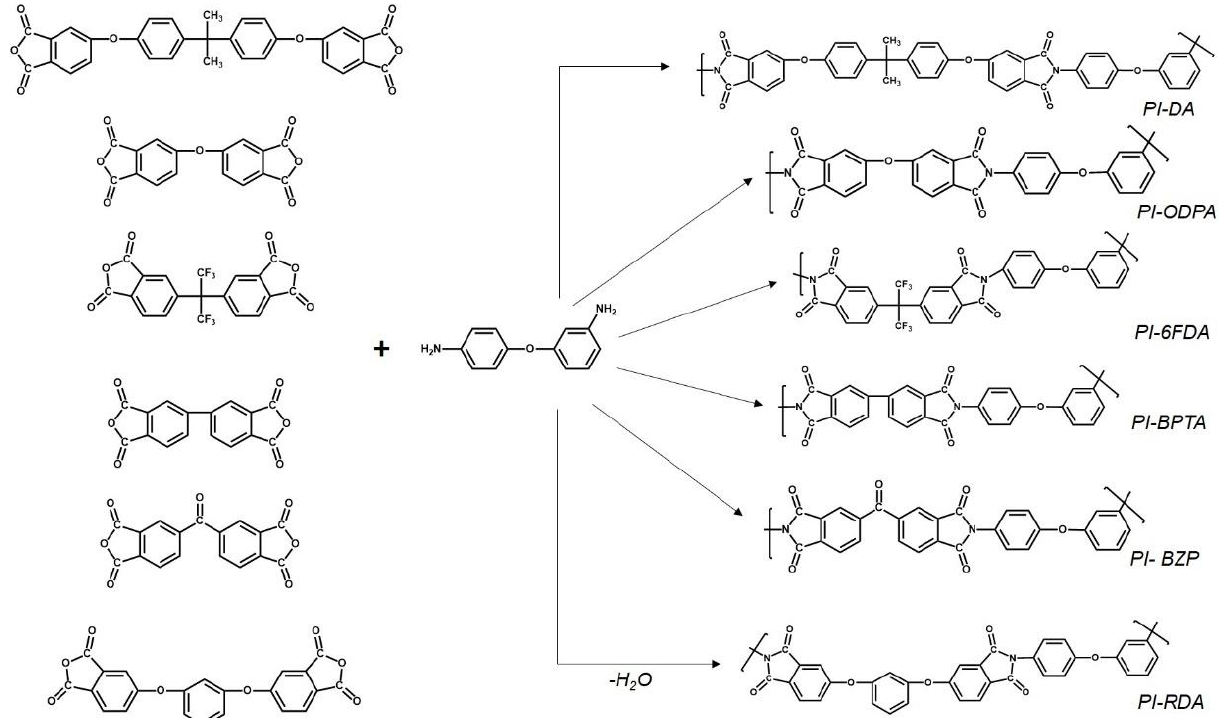
Table 1. Abbreviation of synthesized PIs and their